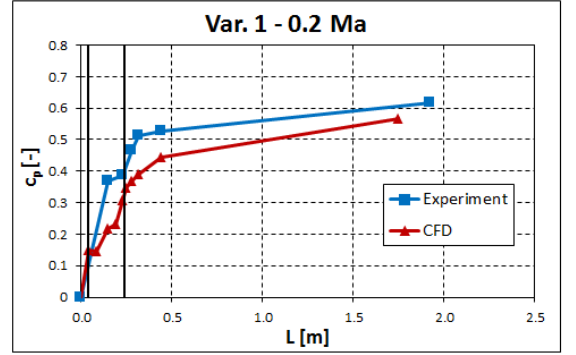
Fig. 18. Result comparison - full hood.